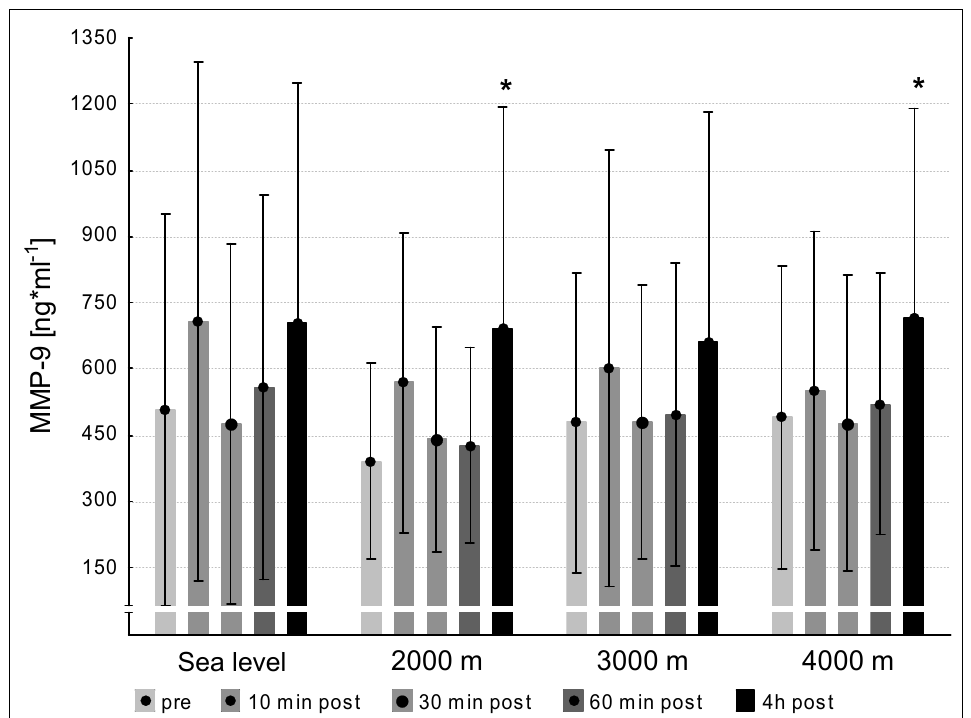
Figure 4. MMP-9 concentration at the five measurement time points (pre, 10 min post, 30 min post, 60 min post, 240 min post exercise) during the different ambient conditions (sea level, 2000 m, 3000 m, 4000 m). Mean ± standard deviation. * p < 0.05 to pre.